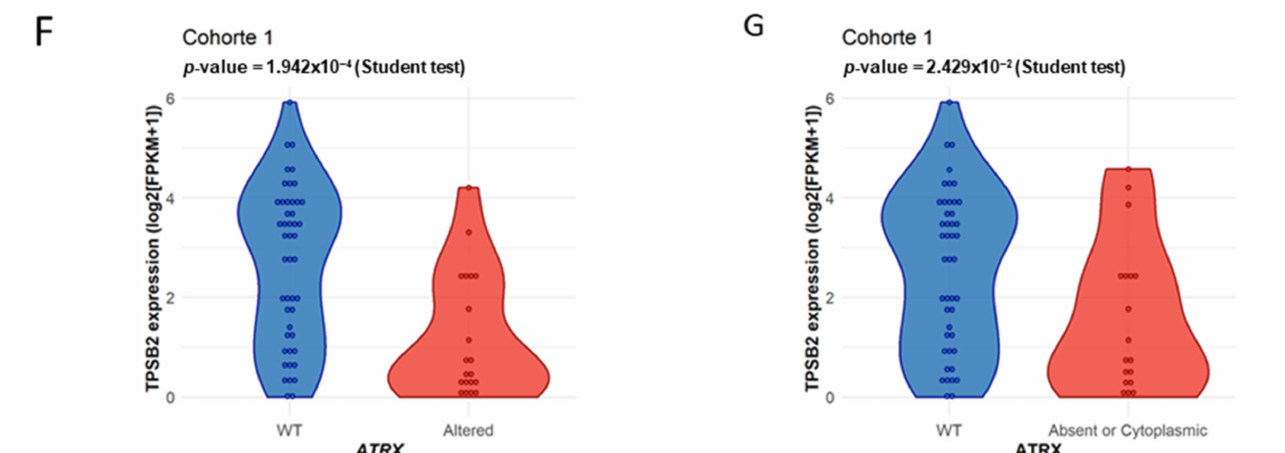
Figure 6. ATRX knock-down allows immune escape of sarcomas via non-recruitment of mast cells. ( A ) Tumor growth rate analysis of K7M2 ATRX CT or K7M2 ATRX KD cells xenografted under the skin of NSG or Balb/c mice ( n = 15 in each group). ( B ) Tumor-free survival curves of K7M2 ATRX CT or ATRX KD tumors in immunodeficient NSG mice and immunocompetent Balb/c mice ( n = 15 mice for each condition) using Kaplan-Meier method. ( C ) Comparison of RNA expression in log2 (FPKM + 1) of K7M2 ATRX KD tumors versus K7M2 ATRX CT tumors developed in immunocompetent mice ( n = 4 each) showing 23 and 37 significantly up- and down-expressed genes in K7M2 ATRX KD tumors, respectively. ( D ) Links between down-expressed genes in K7M2 ATRX KD tumors found by the STRING Database showing one cluster with genes involved in mast cells via MCL clustering. ( E ) Immunostaining of mast cells by targeting tryptase in K7M2 ATRX CT and K7M2 ATRX KD tumor tissues with nucleus marked with DAPI. On the right, percent of mast cells in the two conditions. ( F ) TPSB2 mRNA expression in log2 (FPKM + 1) according to ATRX status in cohort 1. ( G ) TPSB2 mRNA expression in log2 (FPKM + 1) according to ATRX localization in cohort 1. * p ≤ 0.05, p -value was calculated with Mantel-Cox test for ( B ) and unpaired t -test for ( E – G